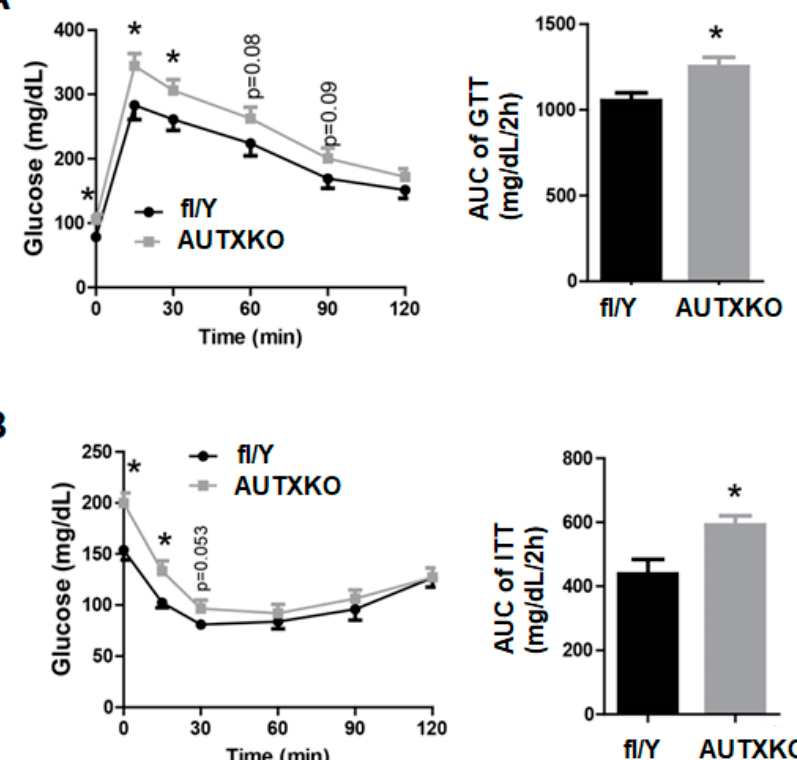
Figure 3. Utx deficiency in adipocytes causes glucose intolerance in mice fed a chow diet. Three- week-old male AUTXKO and fl/Y animals were maintained on a regular chow diet throughout the experiment. ( A ) GTT performed in 31-week-old male AUTXKO and fl/Y animals. ( B ) ITT performed in 32-week-old male AUTXKO and fl/Y animals. All data are presented as mean ± S.E.M.; n = 8/group; * p < 0.05 vs. fl/Y .